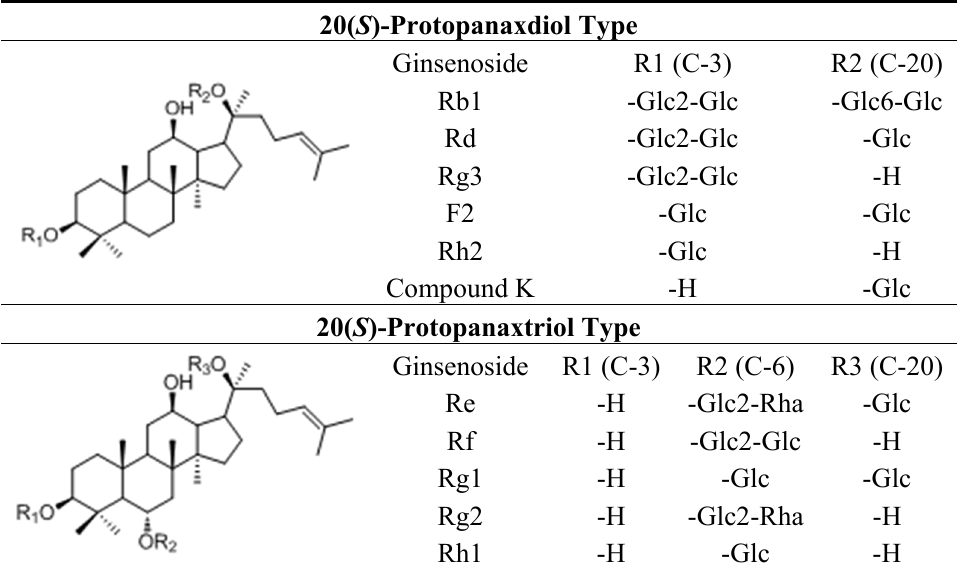
Table 1. Chemical structure of major and rare ginsenosides in Panax ginseng